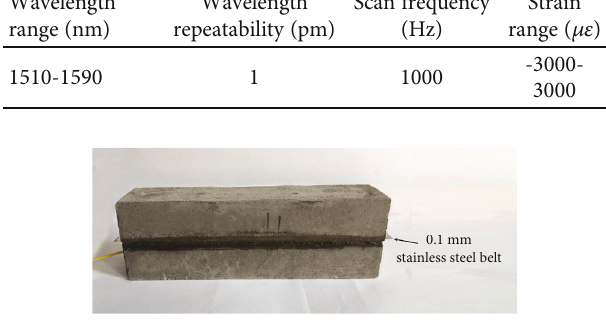
Figure 3: Combination of the core